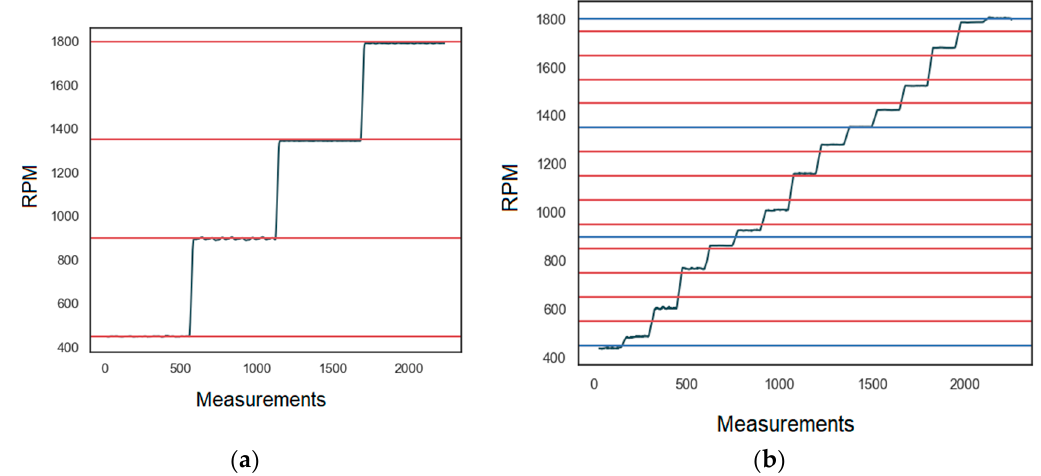
Figure 10. Speed prediction: ( a ) for the cases on which the network was trained and ( b ) for in-between cases (smoothed using a moving average function with m = 5); the red lines show the real test-rig speeds, while the black lines show the predicted speeds.